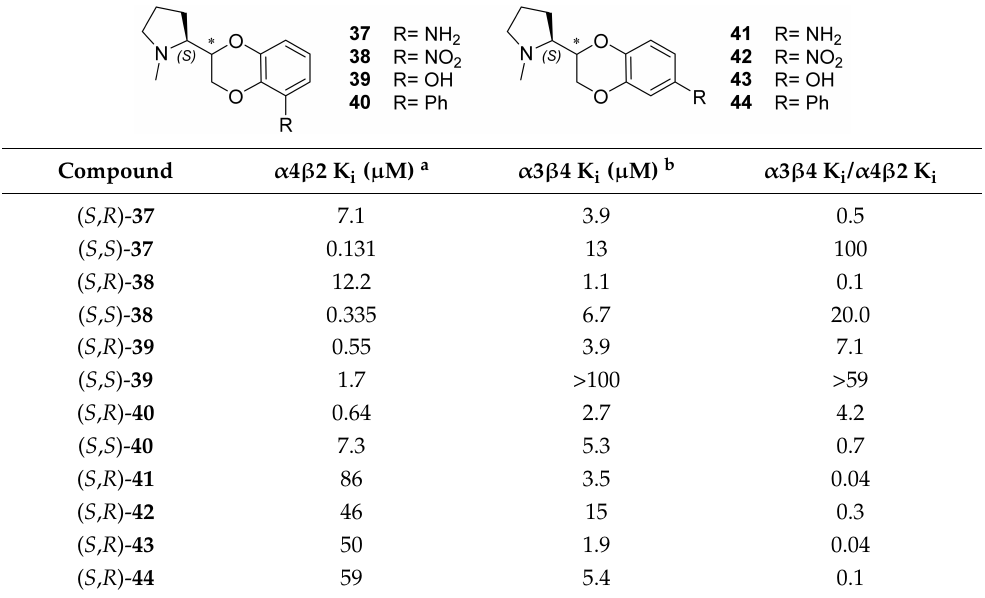
Table 6. Binding affinity data at α 4 β 2 and α 3 β 4 nAChRs and α 4 β 2 vs. α 3 β 4 selectivity ratio of compounds 37 – 44 , from Bavo et al. [33]. a Tested at rat cortex using [ 3 H]-epibatidine. b Tested at membranes of human α 3 β 4 transfected